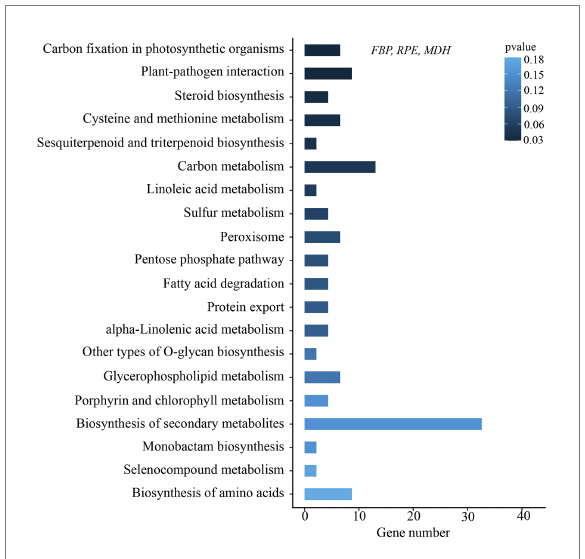
FIGURE 6 Distribution of KEGG classifications of PSGs in I. hypsophila